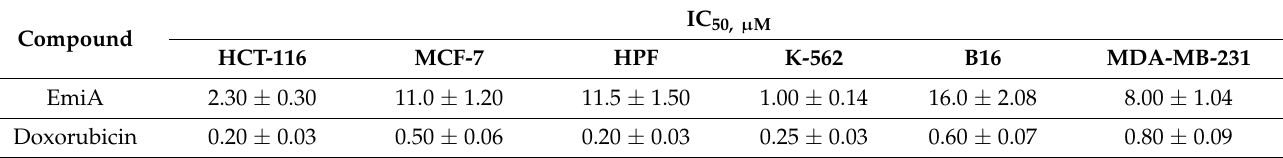
Table 6. IC 50 values of emericellipsin A compared with a control antitumor antibiotic (doxorubicin).